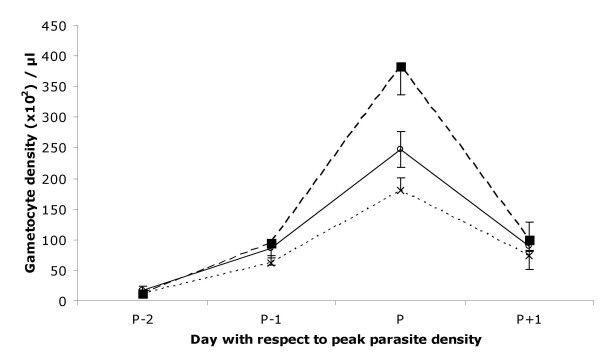
P. gallinaceum gametocyte (sexual) parasite density (mean ± S.E.) following intra-muscular injection of 106 parasites single clones or 5 × 105 of each clone in mixed infections. Thai clone (square, long dotted line); SL clone (open circles, solid line); mixed clones (cross, dotted line).